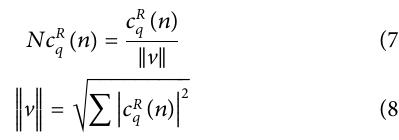
repetition. Two different colours; black and red are used in Table 1 for better showing the repetition.